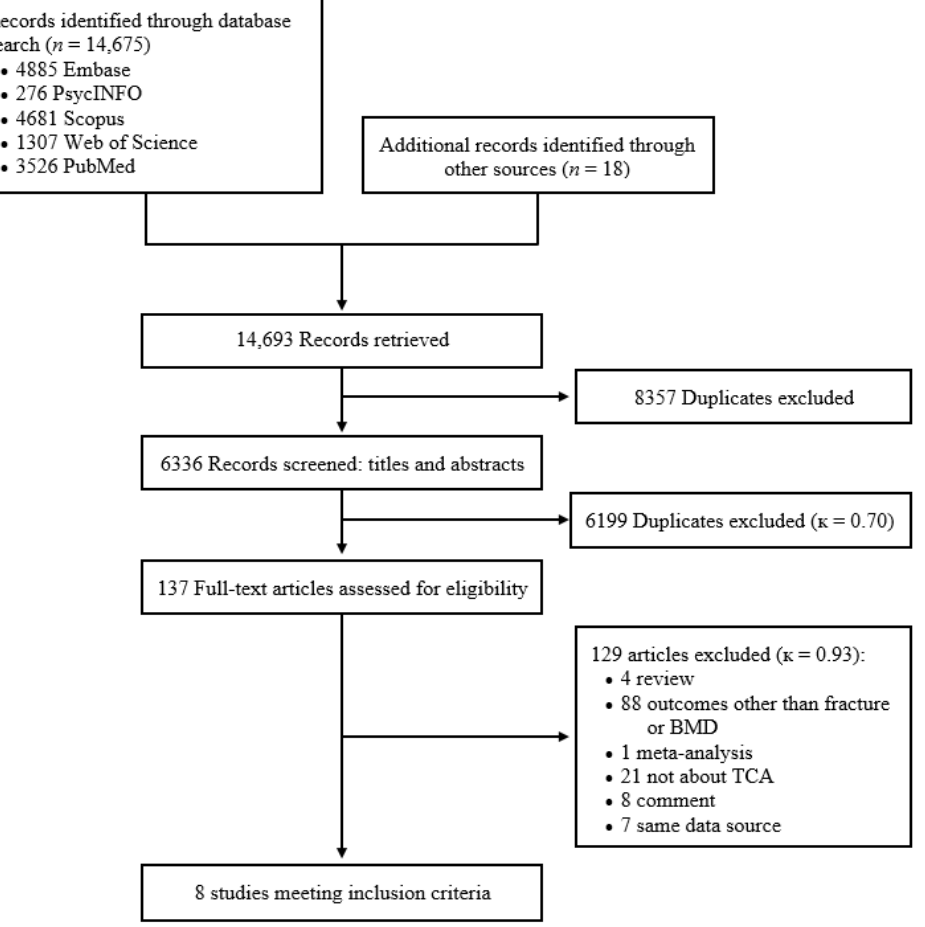
Figure 1. PRISMA flow chart of the study selection (BMD, bone mineral density, TCAs, tricyclic antidepressants).